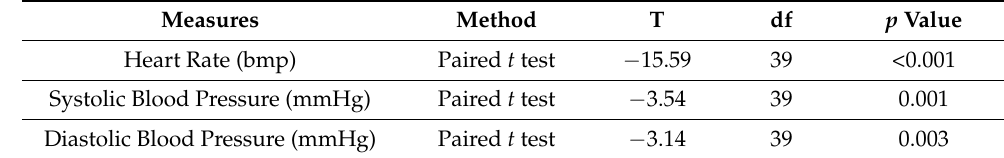
Table 3. Test on whether 10 min of TSST produced significant stress on participants.